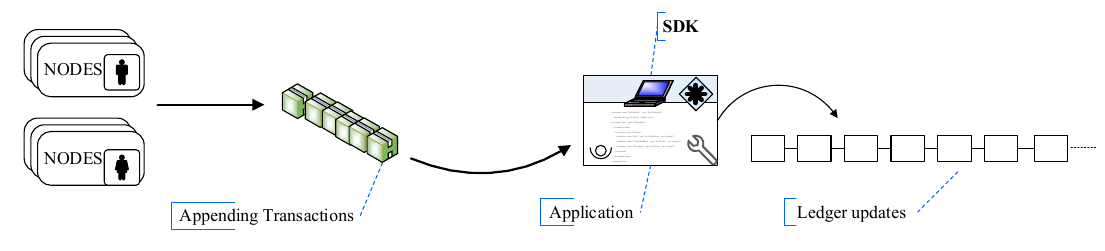
Figure 13. Updating the Hyperledger.